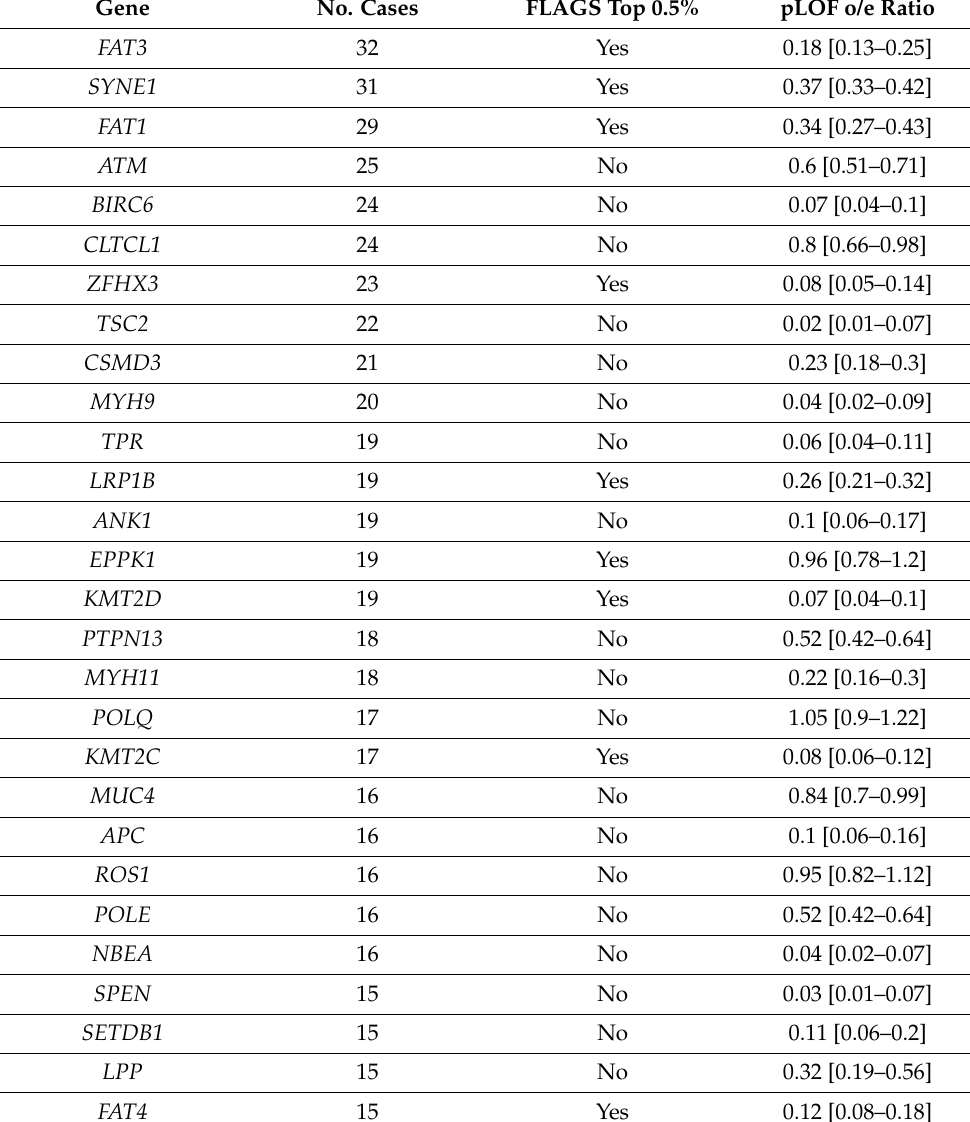
Table 3. List of the most recurrently affected genes by rare and predictively disruptive germline variants. Genes in the top 0.5% of the FLAGS list are indicated, as well as predicted loss-of-function (pLOF) observed vs. expected ratio (o/e ratio) along with its 90% confidence interval. Gene No. Cases FLAGS Top